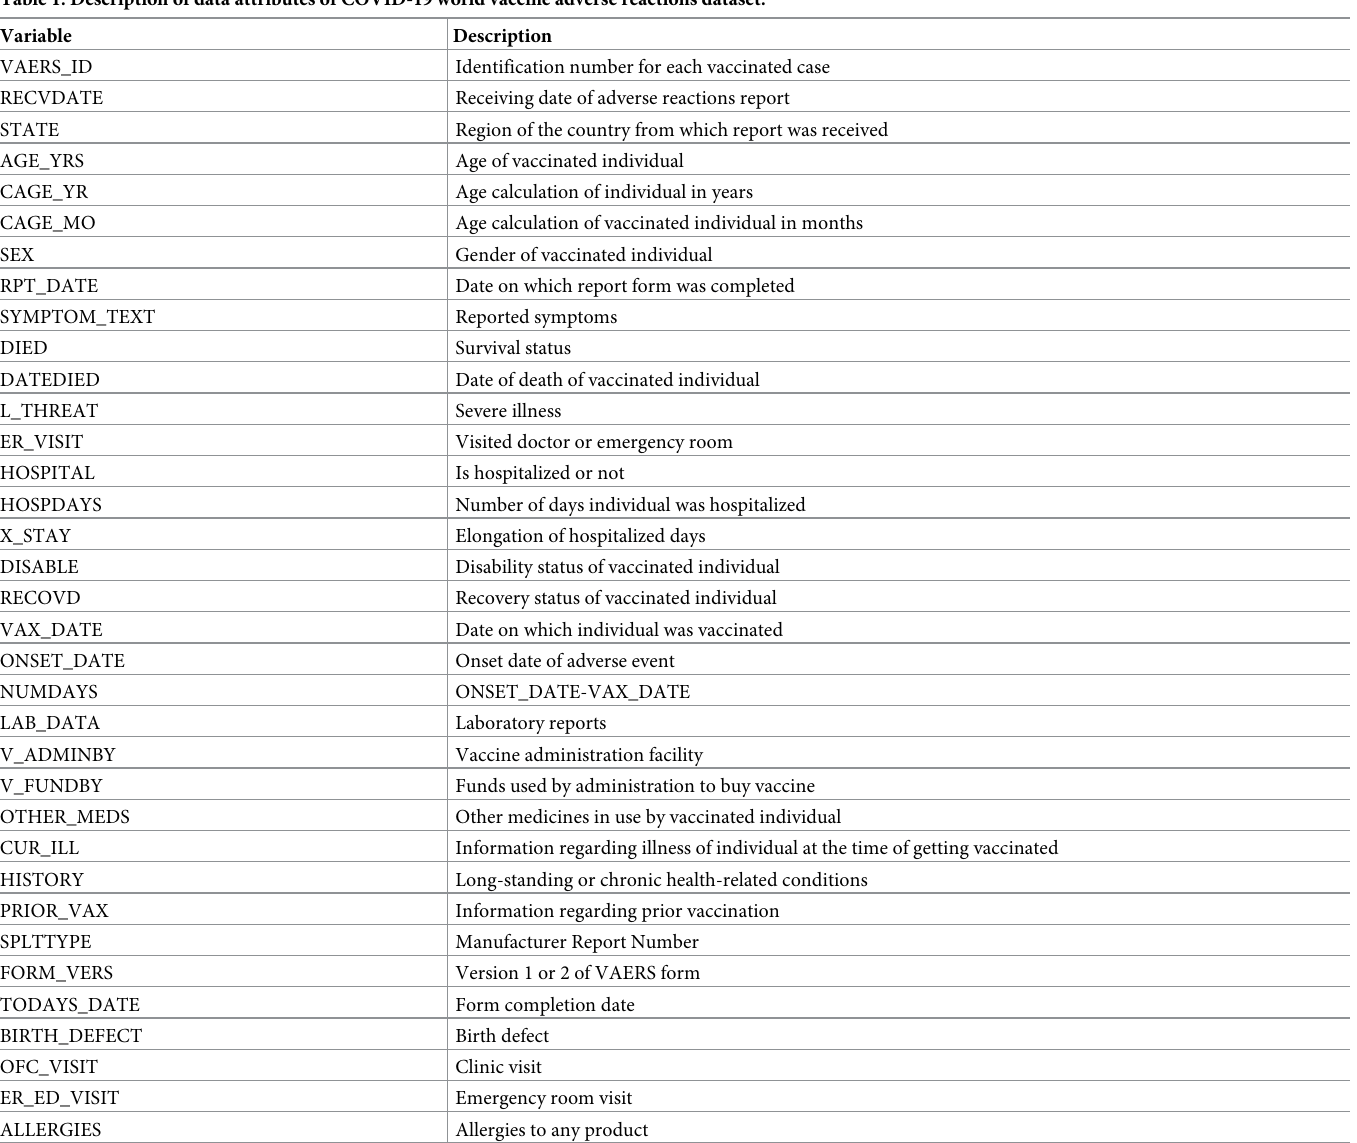
Table 1. Description of data attributes of COVID-19 world vaccine adverse reactions